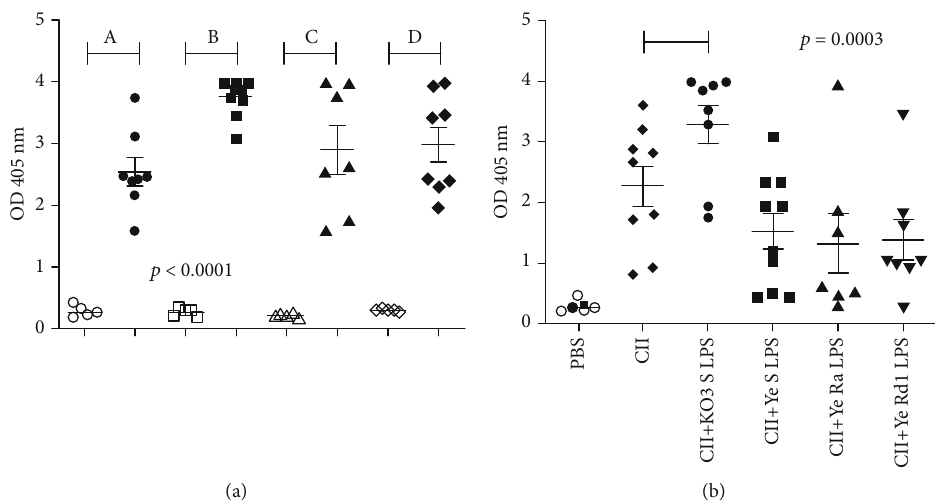
Figure 6: Immunogenicity (a) and adjuvant properties (b) of tested LPS. (a) The antibodies against KO3 LPS (A), YeO3 S LPS (B), Ye Ra LPS (C), and Ye Rd1 LPS (D) were tested in sera (1:5) of mice injected with PBS (open symbols) or corresponding LPS (closed symbols). (b) The antibodies against type II collagen were tested in sera (1:200) obtained from animals treated with PBS only, CII alone, or the mixture of CII and tested LPS; the antibodies against CII were detected. The results were analyzed with an ANOVA Kruskal-Wallis with Dunn ’ s post hoc test. The individual values, means, and SEM are presented. Horizontal lines show the statistically signi fi cant di ff erences between analyzed